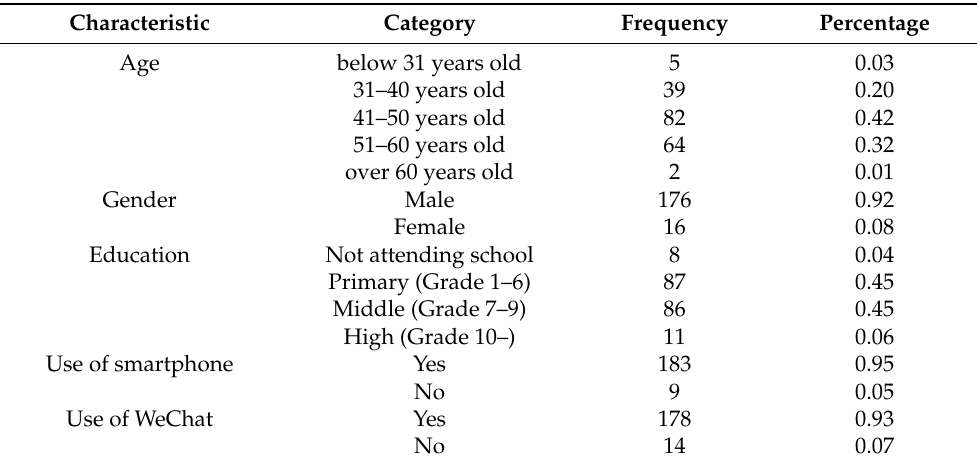
Table 3. Characteristics of the sample ecological forest